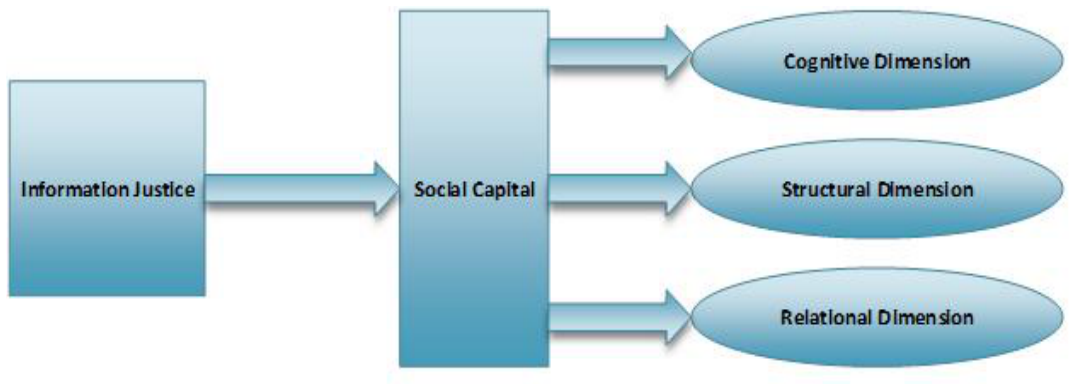
Fig. 1: Conceptual model of research